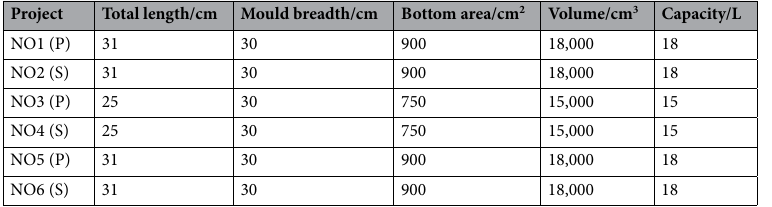
Table 3. Parameters of the ballast